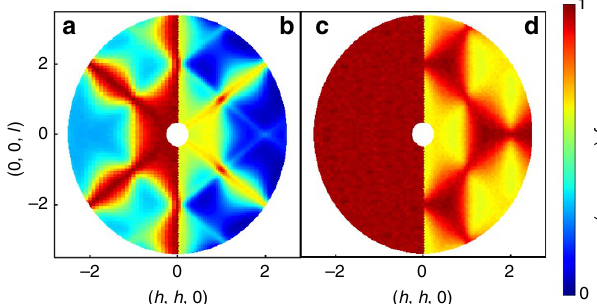
Figure 1 | Comparison of correlations in spin-ice with those of the spin-liquid discussed in this work. Predictions for polarized neutron scattering experiments are shown in the ( a , b ) SF and ( c , d ) NSF channels, as measured by Fennell et al. 10,11 . ( a ) Prediction for spin-ice in the SF channel exhibiting pinch-point singularities. ( b ) Prediction for scattering in the SF channel in the spin-liquid discussed in this work. ( c ) Prediction for spin-ice in the NSF channel. This channel is completely featureless in a nearest neighbour model for spin-ice—as shown here—and develops smooth maxima at the zone boundaries in the presence of long range dipole interactions 10 . ( d ) Prediction for scattering in the NSF channel in the spin-liquid discussed in this work. In contrast to spin-ice, the spin-liquid discussed here exhibits singular features in both SF and NSF scattering. Results are taken from classical Monte Carlo simulation of the nearest neighbour model H ex (equation (1)), as described in the text. NATURE COMMUNICATIONS|7:11572|DOI: